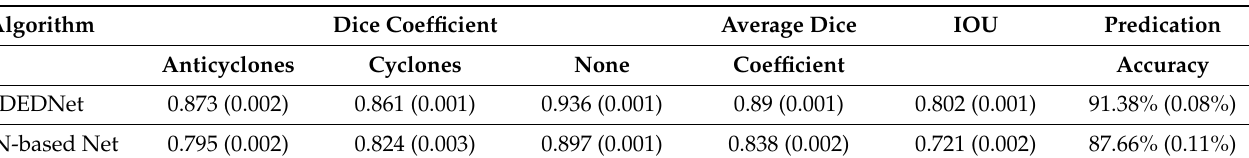
Table 1. The dice coefficient, IOU, and predication accuracy obtained by DEDNet and FCN-based Net on 30-times experiments.